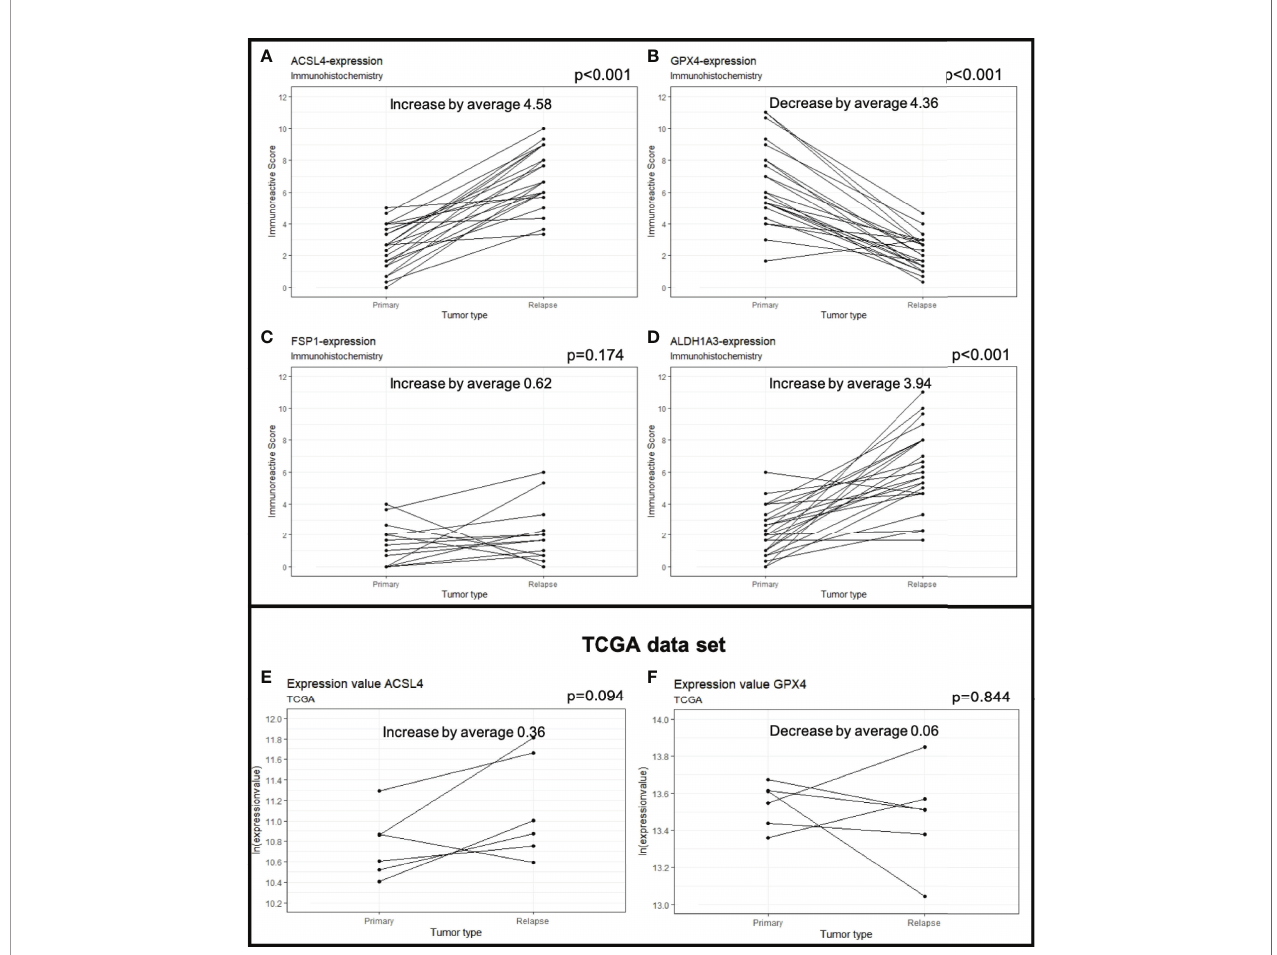
FIGURE 2 | Protein expression in primary and recurrent GBM. The dots mark the level of IRS in the primary and relapse tumor. Each line represents the change in expression of one patient, showing increase of expression for ACSL4 (A) , FSP1 (C) and ALDH1A3 (D) . GPX4 expression decreases signi fi cantly in 23 out of 24 patients (B) . The results were veri fi ed by analyses of the TCGA data set showing an increase in ACSL4 expression (E) and a decrease in GPX4 expression (F)